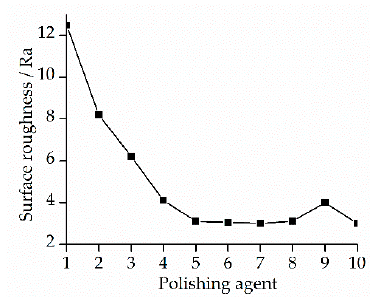
Figure 15. Roughness variation with different kinds of polishing agents.